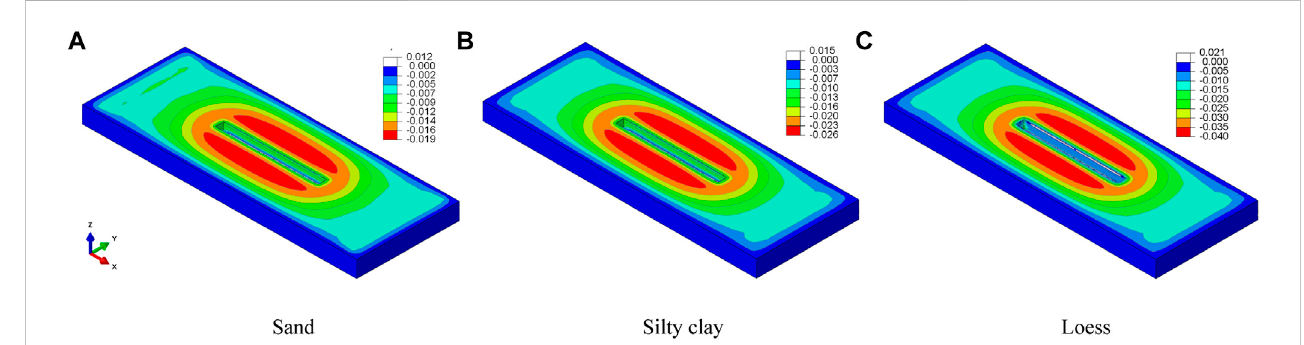
FIGURE 7 Settlement deformation contour after pit excavation (Unit: m). (A) Sand (B) Silty clay (C) Loess.